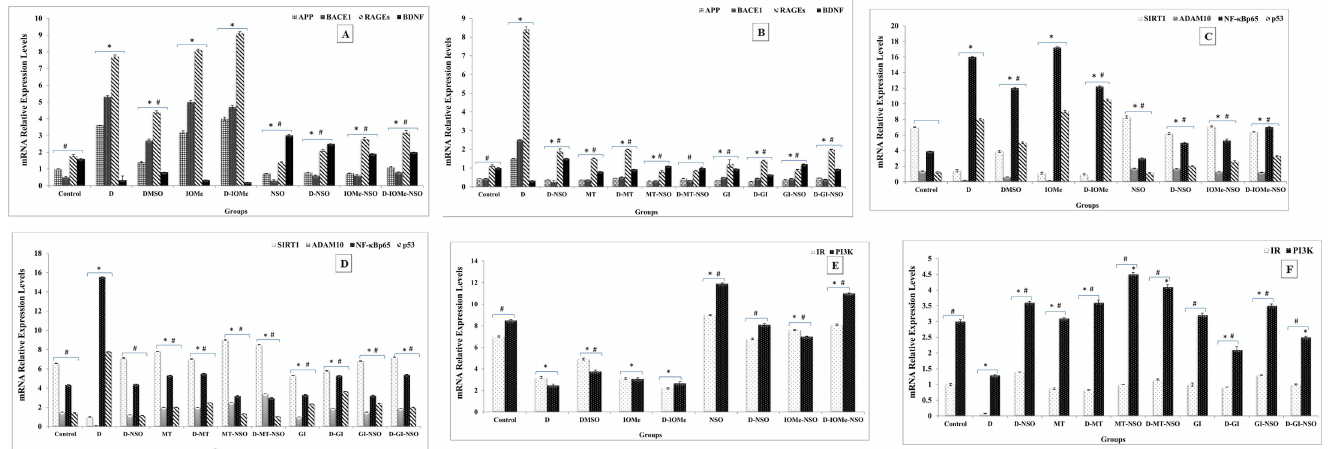
Fig 2. Gene expression profiles of brain amyloidogenic, neuro-protection and insulin signaling biomarkers. mRNA levels by RT-PCR analysisfor APP, BACE1, BDNF and RAGEs in brain tissues of diabeticand I-OMeAG538- injected rats versus NSO- treated rats (A). mRNA levels of APP, BACE1, BDNF and RAGEs in the brain of diabetic rats post the treatment with NSO, reference drugs and combination therapy (B). mRNA levels SIRT1, ADAM10, NF- κ Bp65and p53 in the brain of diabetic rats, I-OMe-injected rats versus NSO treated rats (C). mRNA levels of SIRT1, ADAM10, NF- κ Bp65 and p53 in brain tissues of diabetic rats, and after treatment with NSO, reference drugs and combination therapy for (D). mRNA levels of IR and PI3K in the brain of diabetic rats, I-OMeAG538-injected rats versus NSO treated rats (E). mRNA levels of IR and PI3K in the brain of diabeticrats, and after treatment with NSO, MT, GI and combination therapy for IR and PI3K (F). β -actin was used as an internalcontrol and quantification of bands using UVIBAND Image quantification